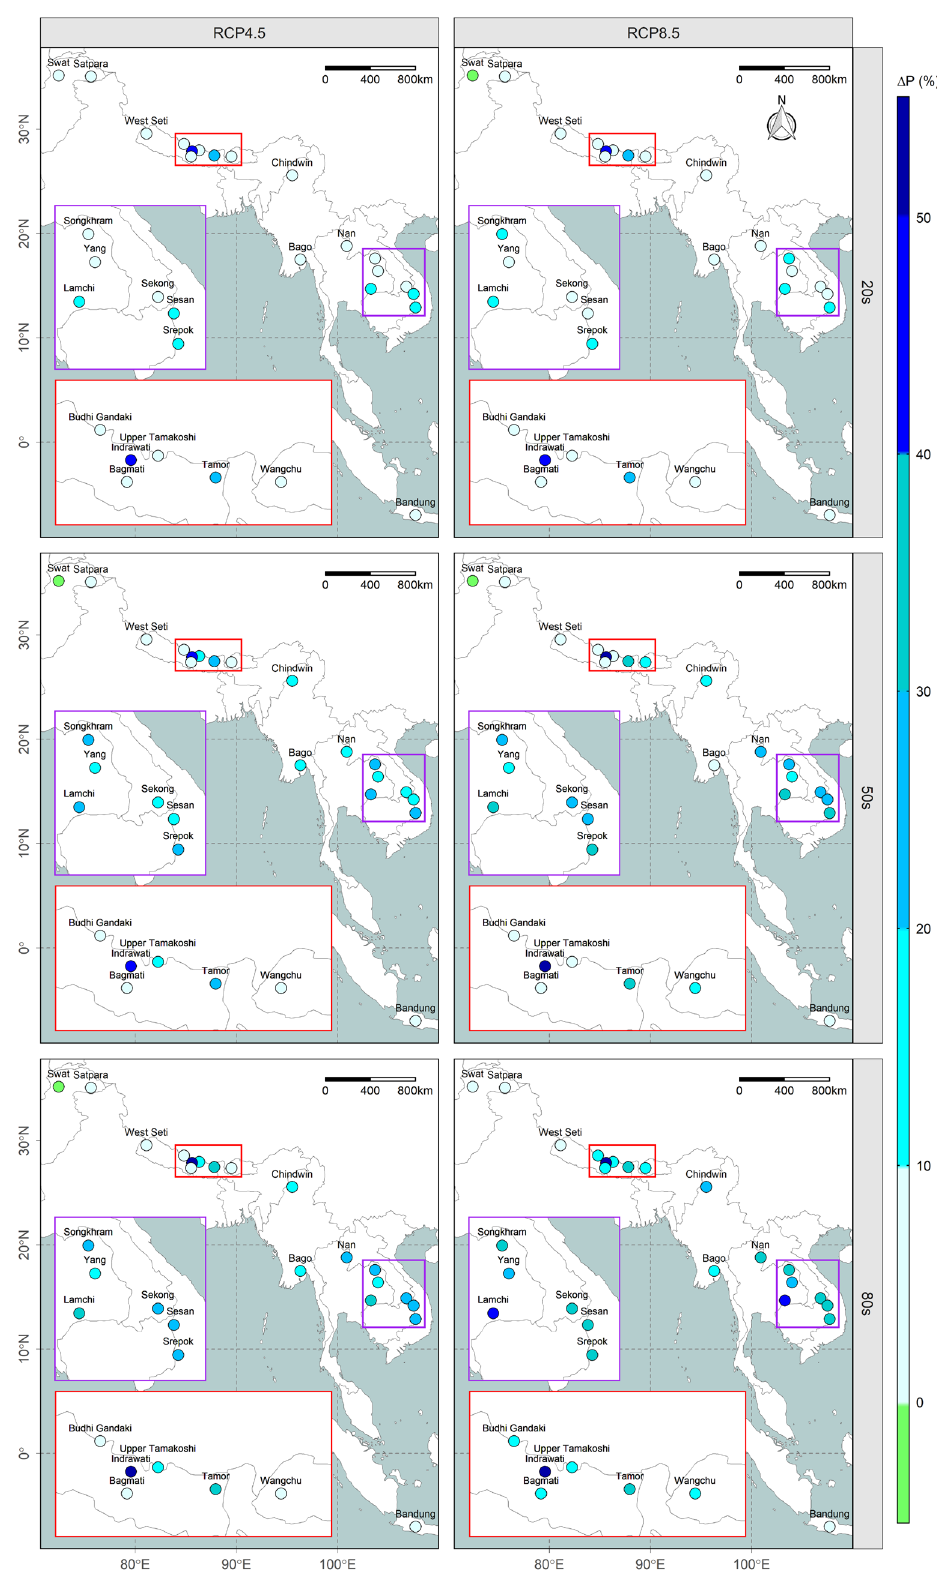
Figure 3. Spatiotemporal variation in the annual precipitation anomaly (% change). The results are from an ensemble of GCMs, with each facet corresponding to different emission scenarios (RCP4.5 or RCP8.5) during various time periods (20 s, 50 s, or 80 s) as indicated at the top and left side of the map, respectively, while the two insets are enlarged and colour-coded 20–22